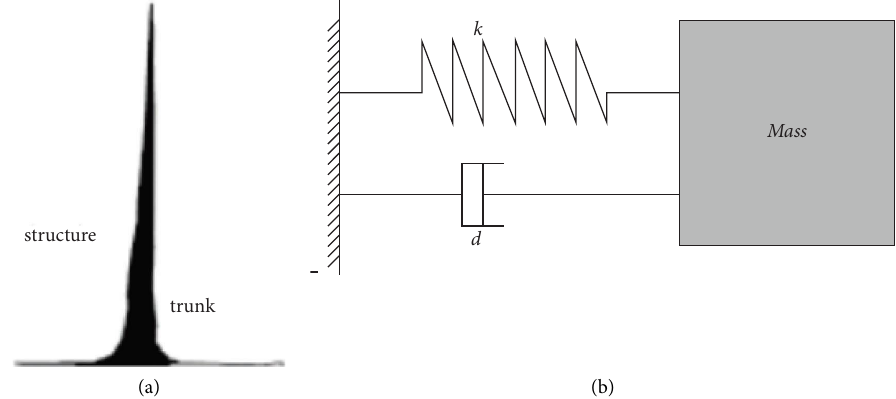
Figure 1: Dynamical model of a tree trunk: (a) structural representation and (b) mechanical equivalent